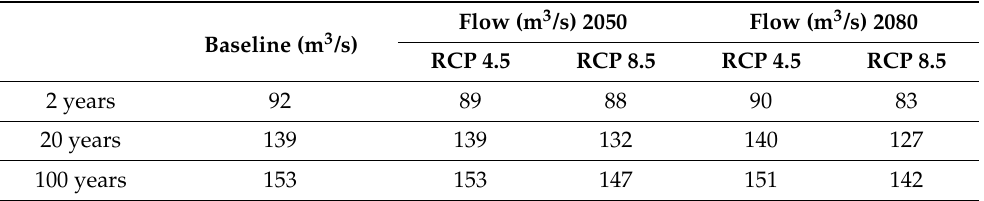
Table 1. Projected peak flow estimated at the 2050- and 2080-time horizons as compared with the baseline flows at the hydrometric Station 040406 (RCP 4.5 and RCP 8.5).